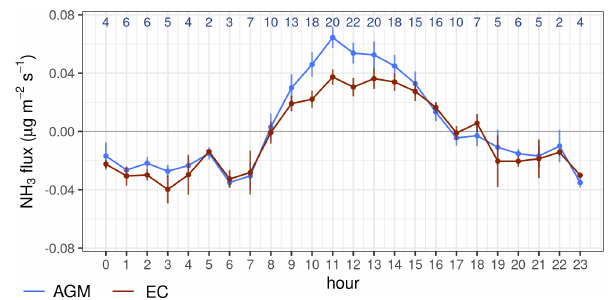
Figure 9. Mean diurnal cycle of the EC and AGM NH 3 fluxes. Pos- itive flux is emission, negative flux is deposition. The error bars indicate the standard error of the hourly means (cid:0) σ/ ber of hours averaged are listed in blue text at the top. Here, filtered NH 3 fluxes from only the green and light green wind directions where both systems have a valid flux observation were used. Data from the 11 September are also excluded due to a potential emission event causing footprint